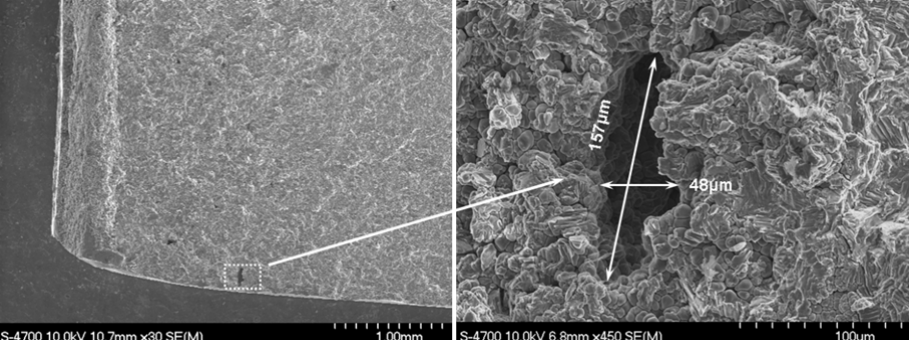
Figure 11. SEM image of a crack initiation site in specimen 27-26 (Fatigue life = 963,520 cycles) [5].